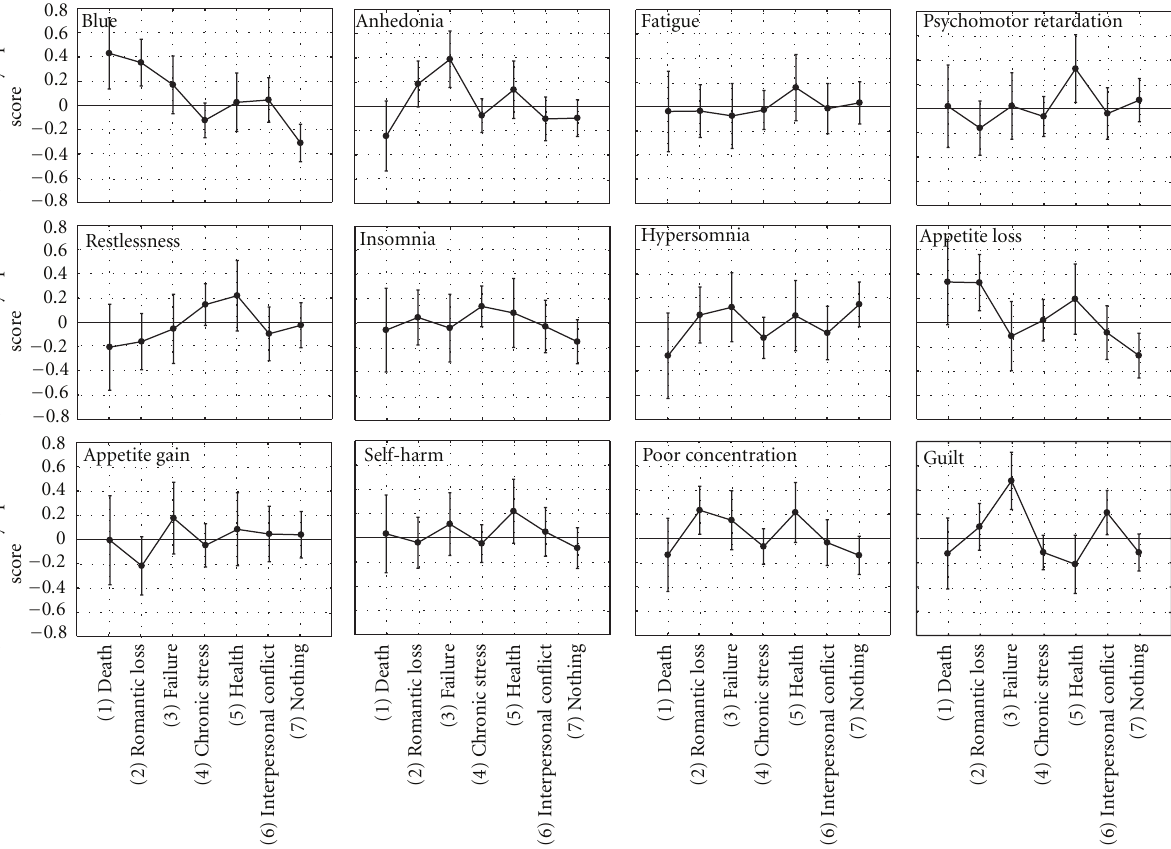
Figure 1: Profiles of average depressive symptom levels for the seven ALEs